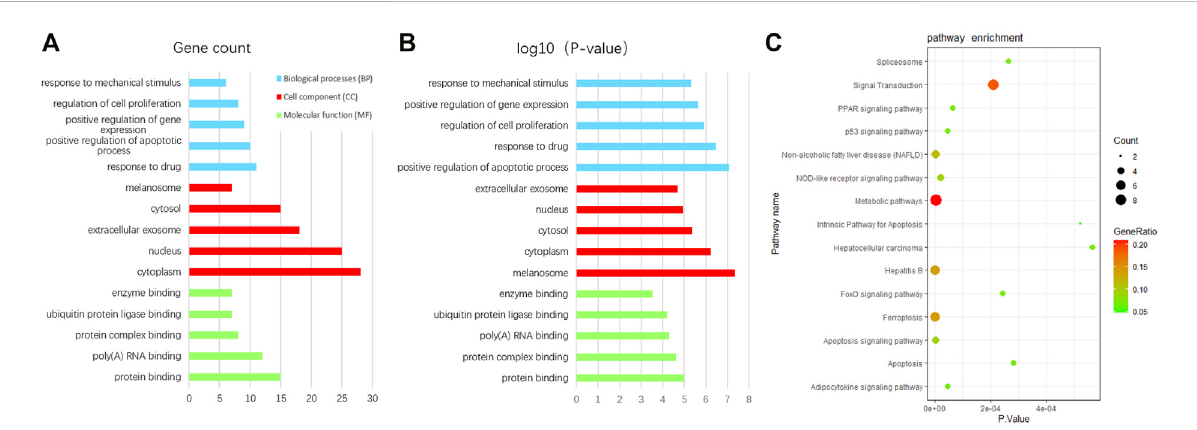
FIGURE 3 GO and pathway enrichment analysis of differentially expressed ferroptosis-related genes (DEFRGs). (A) GO enrichment analyses of DEFRGs with gene count and (B) p -value. (C) pathway enrichment analysis of